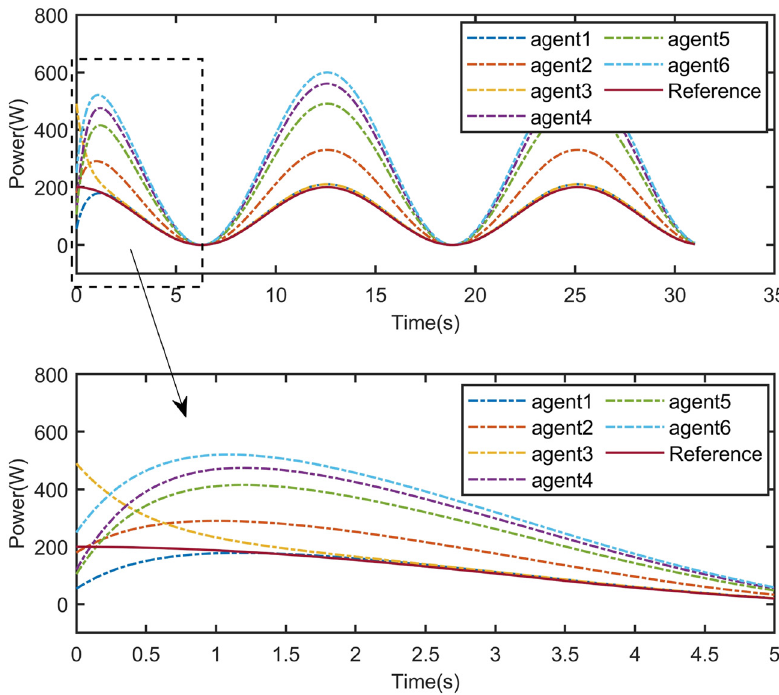
Figure 7: Power consistent output of the microwave source agent with expected power